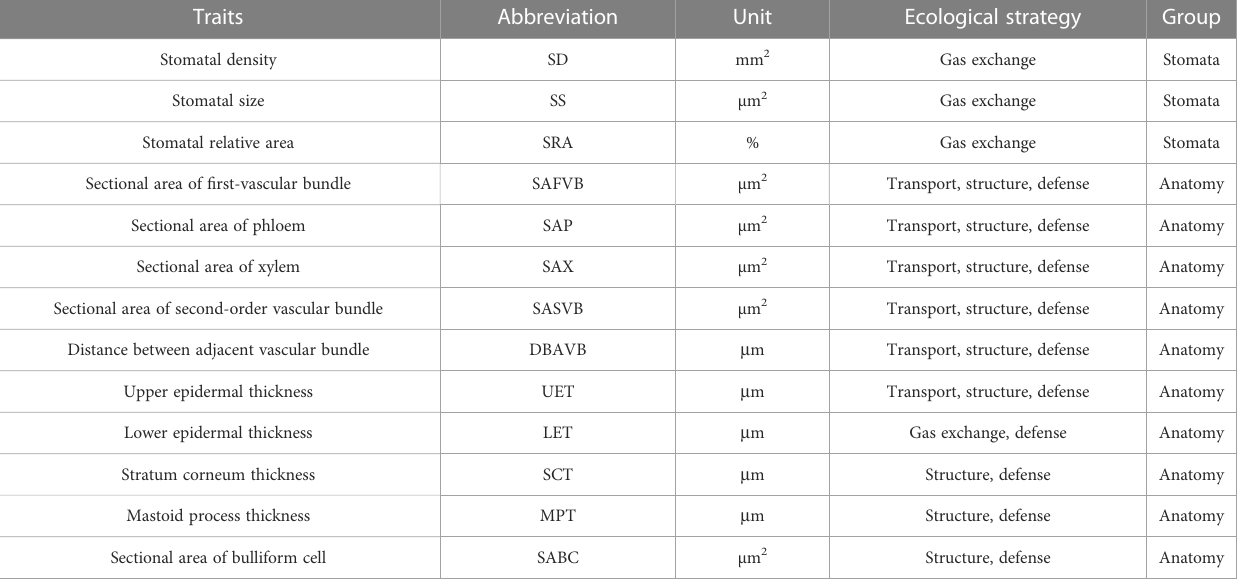
TABLE 1 Leaf stomatal and anatomical traits and their ecological